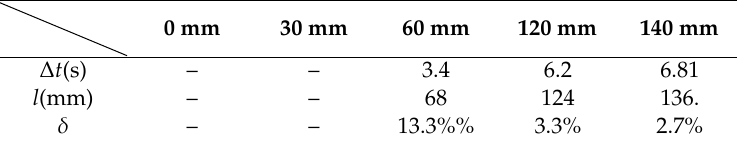
Figure 8. The electric image of identifying boiled egg and eggshell under different value of “X”. Table 3. Analysis table for positioning errors of the boiled egg and eggshell.